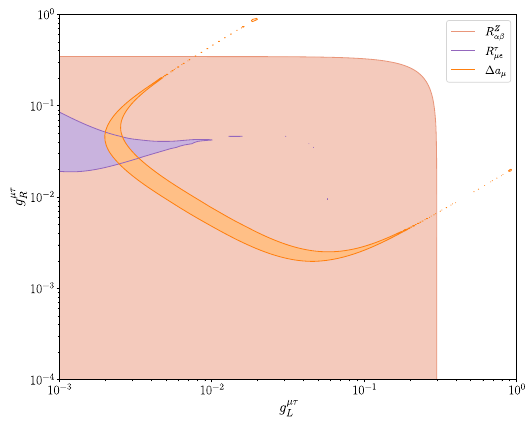
μτ , and prospects for ( g − 2 ) μ . ratios (light orange) and R τ μ e (purple); the dark orange region denotes L , R μτ μτ the 1 σ (cid:2) a μ favoured regime. On the right, detailed (linear) view of - g )param- μτ μτ L R the viable g vs. g parameter space, with the dashed curves now L R corresponding to the 1 σ and 2 σ global fits (see